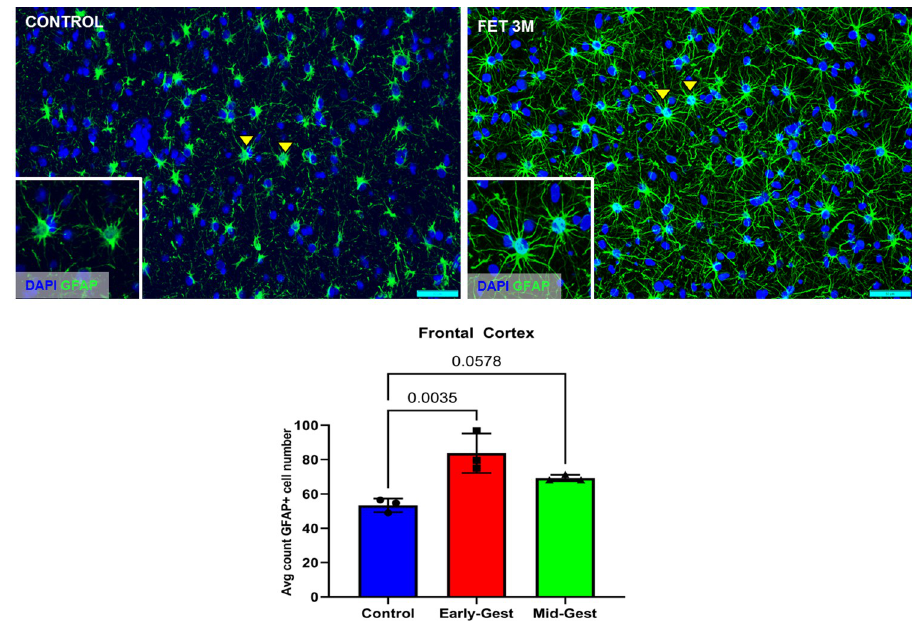
Fig 8. Immunofluorescence (IF) for GFAP representing astrogliosis in the frontal cortex of fetal baboons from early and mid-gestation ZIKV inoculated dams compared to the control fetal brains. In fetal frontal cortices from both early and mid-gestation ZIKV inoculated dams, significant increase in GFAP+ cell population was seen. GFAP immunoreactive cells also visually appeared to have increased GFAP staining intensity and morphological changes such as longer and more ramified cellular processes compared to control brains (arrow and inset). (Scale bar = 50 μ m; Error bars depict SD, Dunnett’s multiple comparison test was done for statistical analysis, p < 0.05 considered